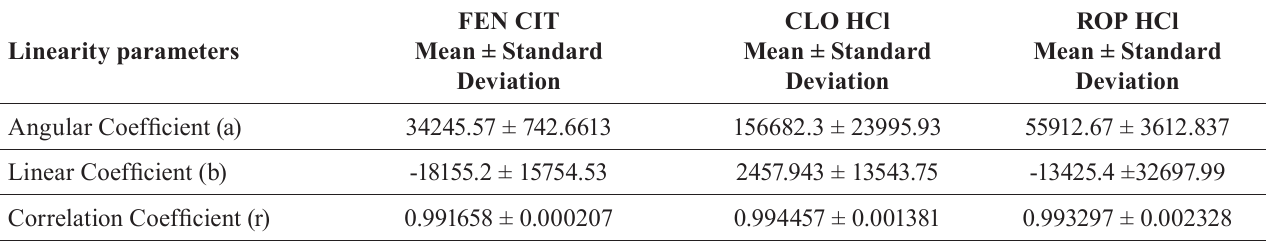
TABLE II - Linearity parameters of the analytical method